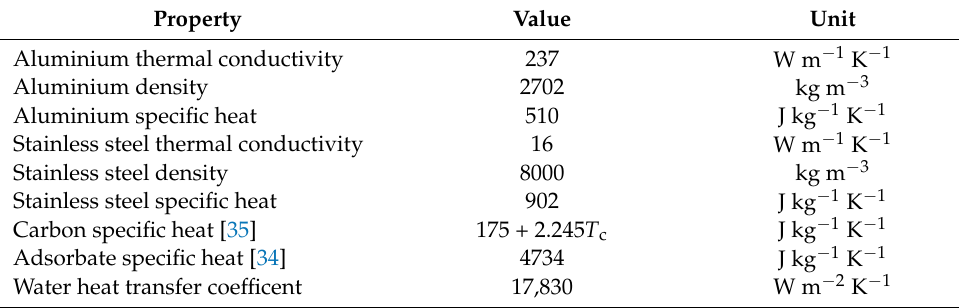
Table 4. Property values used in the computational